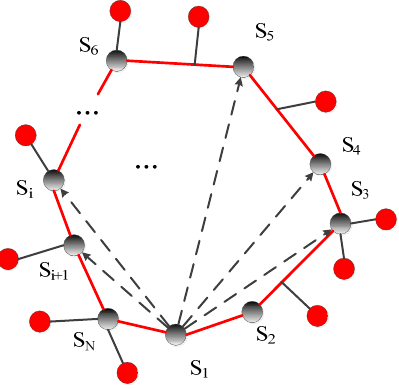
Figure 5. The determined convex hull obtained by Algorithm 1.